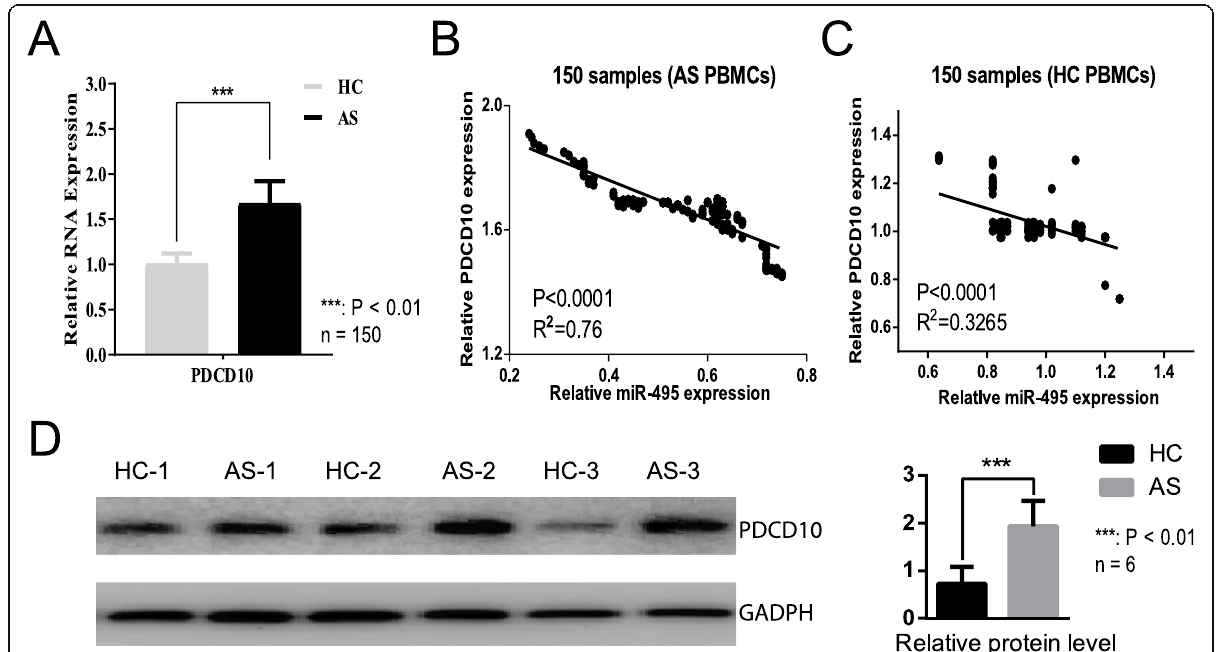
Fig. 3 Expression of PDCD10 . a qPCR of PDCD10 . The expression levels were presented as the mean + SD and calculated by 2 - △△ ct . PDCD10 expression in healthy controls and patients with AS was 1.01 + 0.116 and 1.68 + 0.241, respectively. b Correlation analysis between PDCD10 and miR-495 expression in patients with AS. c Correlation analysis between PDCD10 and miR-495 expression in healthy controls. d Western blot of PDCD10 . HC-1, HC-2, HC-3: different healthy controls. AS-1, AS-2, AS-3: different patients with AS. GADPH used as internal reference. The PDCD10 protein levels were also showed as the histogram. n = 150 or 6: tested samples in each group. PBMCs: peripheral blood mononuclear cells. AS: patients with ankylosing spondylitis. HC: healthy controls. ***: P value <